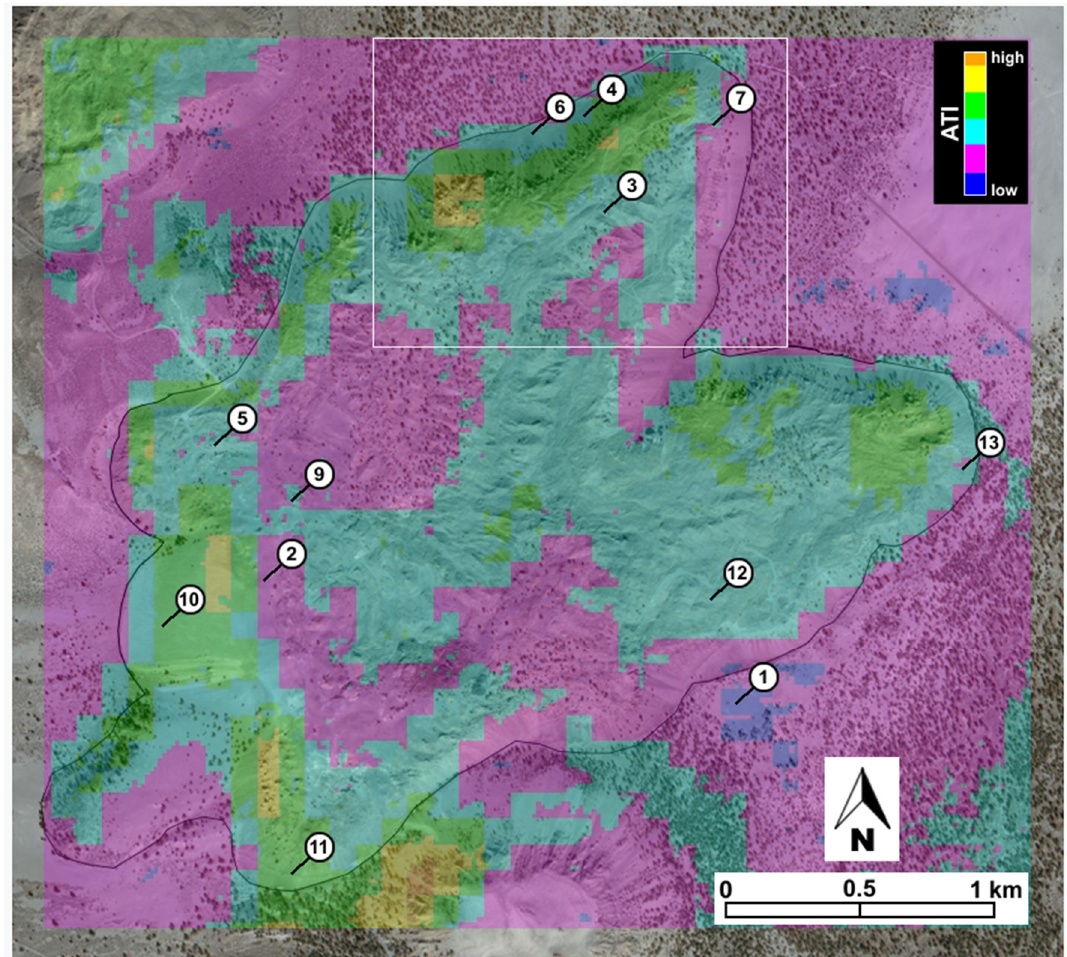
Figure 3. Relative apparent thermal inertia image of North Coulee (outlined in black) derived from 10 July 2011 ASTER data (created by Ramsey and Crown, 2010) [4]. The colorized scale image is overlain on a Digital Globe (within Google Earth) high-resolution color image for detail. This image was used as a guide for later fieldwork and the numbered pins refer to visited field sites. The white box denotes the area shown in Figure 6. Data courtesy of NASA/GSFC/METI/Japan Space Systems. U.S./Japan ASTER Science Team.